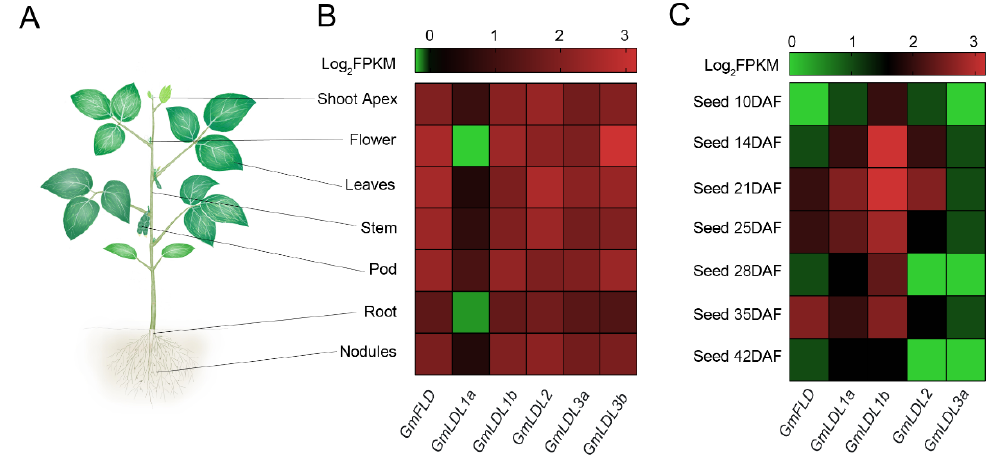
Figure 3. Expression patterns of GmLDL genes. ( A ) A diagram of the investigated plant tissue. These tissues include shoot apex, flower, leaves, stem, pod, root, and nodules. ( B ) Expression patterns of GmLDL genes in different tissues. ( C ) Expression patterns of GmLDL genes at different developmental stages of the seed. The color scale above the heat map indicates the gene expression levels. The green color indicates a low expression level and the red color indicates a high expression level, the number 3 is the highest, and 0 is the lowest.